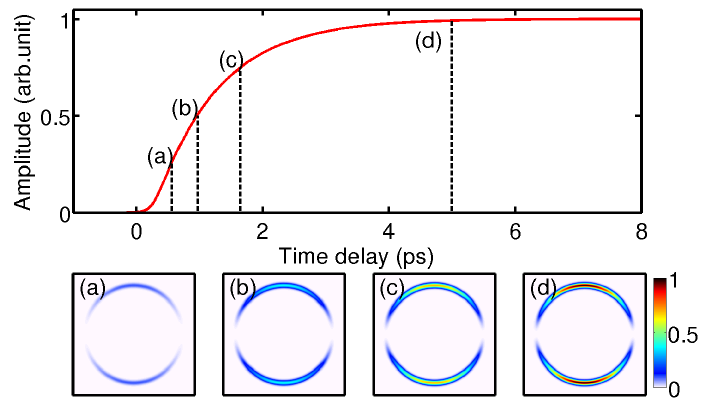
Figure 2. Time evolution of a contribution with a temporal behavior described by Equation (5) with τ d = 1 ps, t 0 = 250 fs and where I xc ( t ) is a Gaussian function with a full-width-at-half-maximum (FWHM) of τ xc = 300 fs. The images shown below correspond to the contribution depicted in Figure 1 at selected delay times. The images labelled ( a – d ) correspond to the time delays depicted in the transient shown in the top